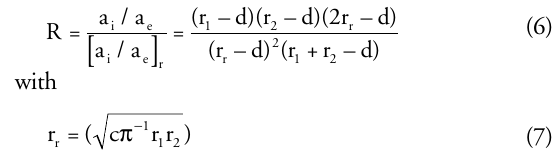
/a . A: circular shape i e